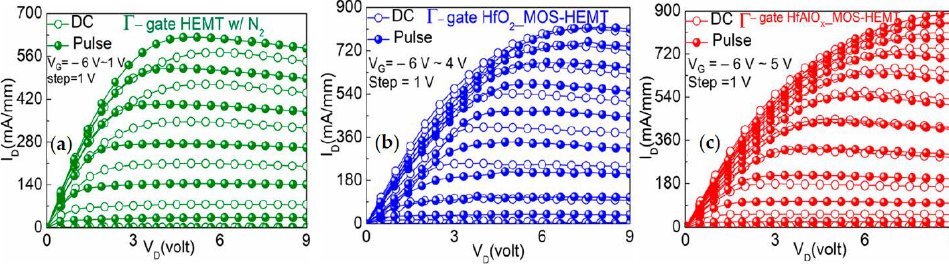
Figure 8. Comparison of pulsed I D -V D characteristics of ( a ) Γ -shaped gate HEMT, ( b ) HfO 2 , and ( c ) HfAlO X MOS-HEMT with the N 2 plasma treatment.